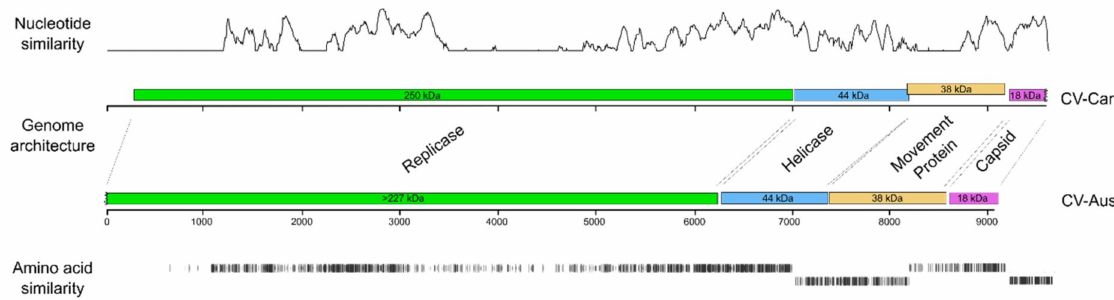
Figure 1. Comparison of two Charavirus genomes; gene map and similarities of nucleotide sequences and predicted amino acids. The nucleotide similarity axis positively correlated with the similarity score. Predicted weight of putative proteins are indicated in kilo Daltons (kDa); identical amino acids in black, similar amino acids in grey and in line with the open reading frame (ORF) of Charavirus canadensis